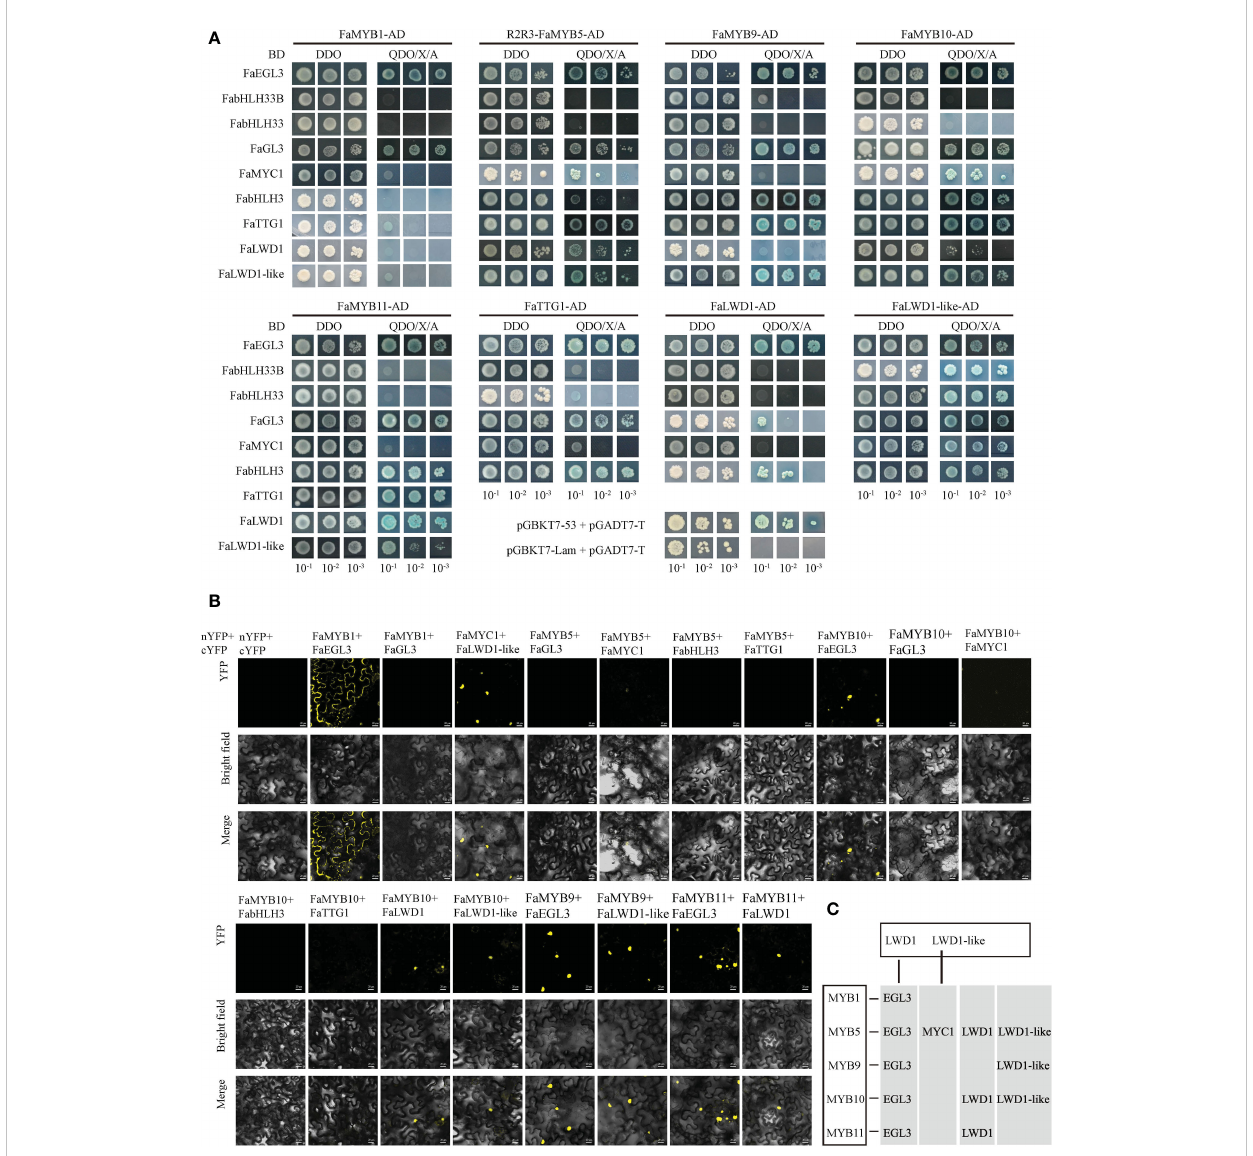
FIGURE 3 Screening of interacting proteins. (A) Validation of interacting proteins using the Y2H method. DDO: SD/-Trp/-Leu, QDO/X/A: SD/-Trp/-Leu/-His/- Ade/+X- a -gal/+AbA, positive control was pGADT7-T + pGBKT7-53 and pGADT7-T + pGBKT7-Lam as negative control. (B) Protein-protein interaction veri fi ed by BiFC assay. Scale bars represent 20 µm. (C) Diagram of the interaction relationship con fi rmed by BiFC and